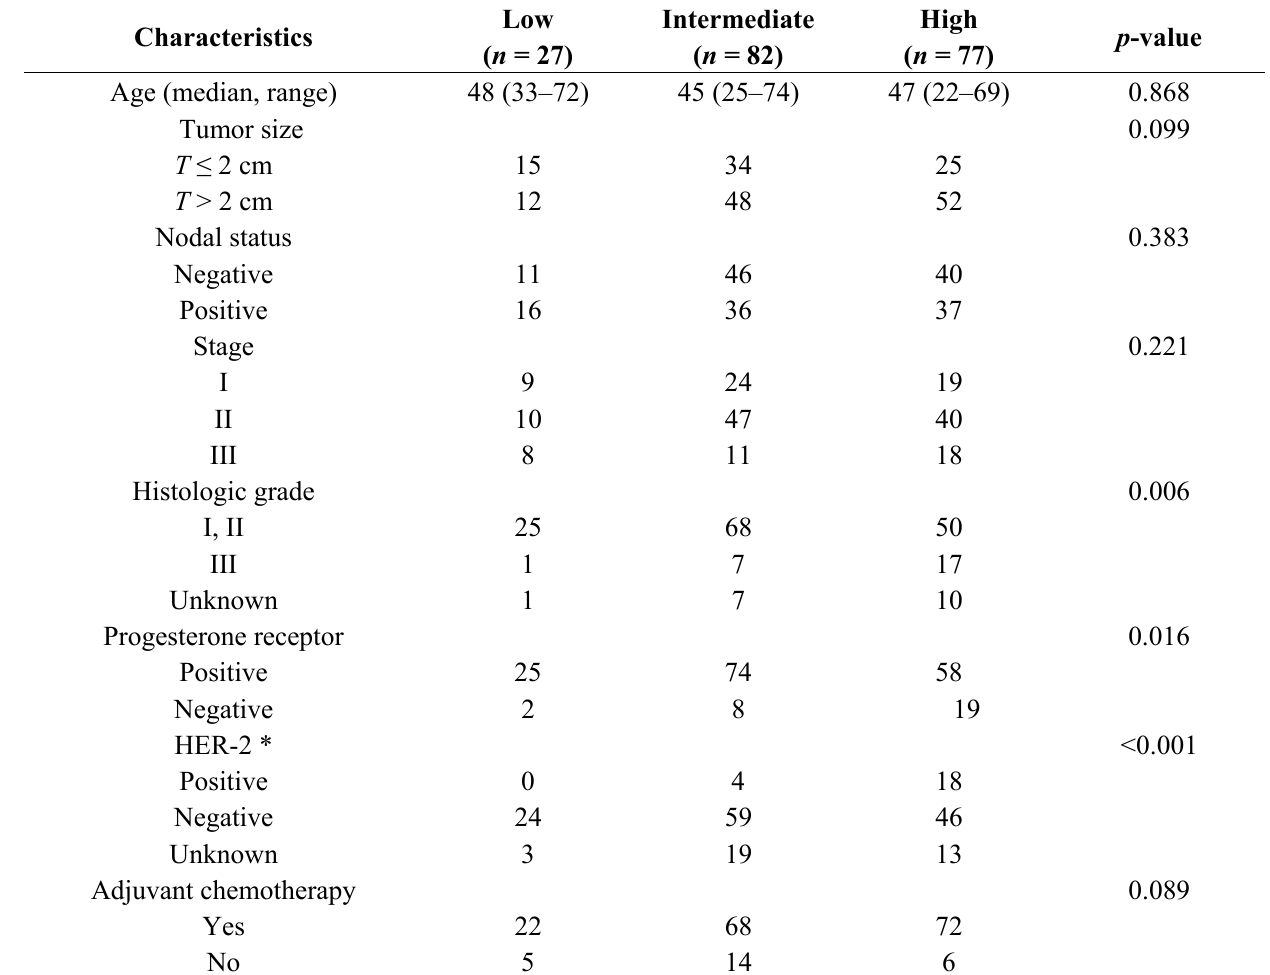
Table 1. Baseline characteristics according to the recurrence score (RS) predictor in estrogen receptor (ER)-positive patients ( n =